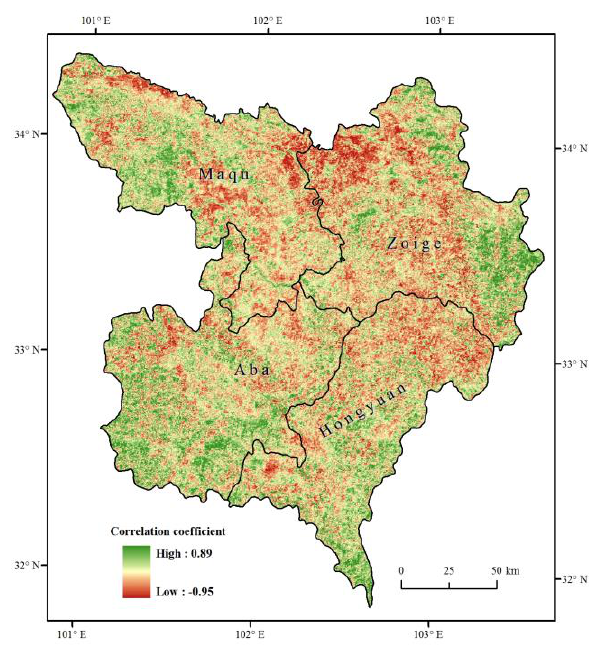
Figure 7. Correlation between annual EVI and